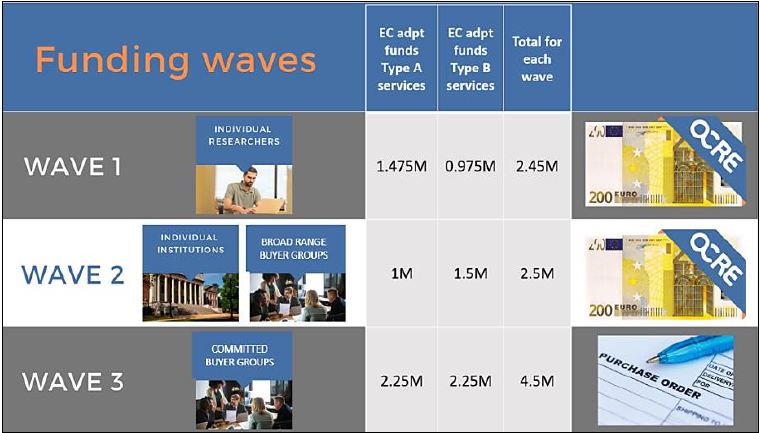
Figure 3. Users, services and preliminary allocation of funding